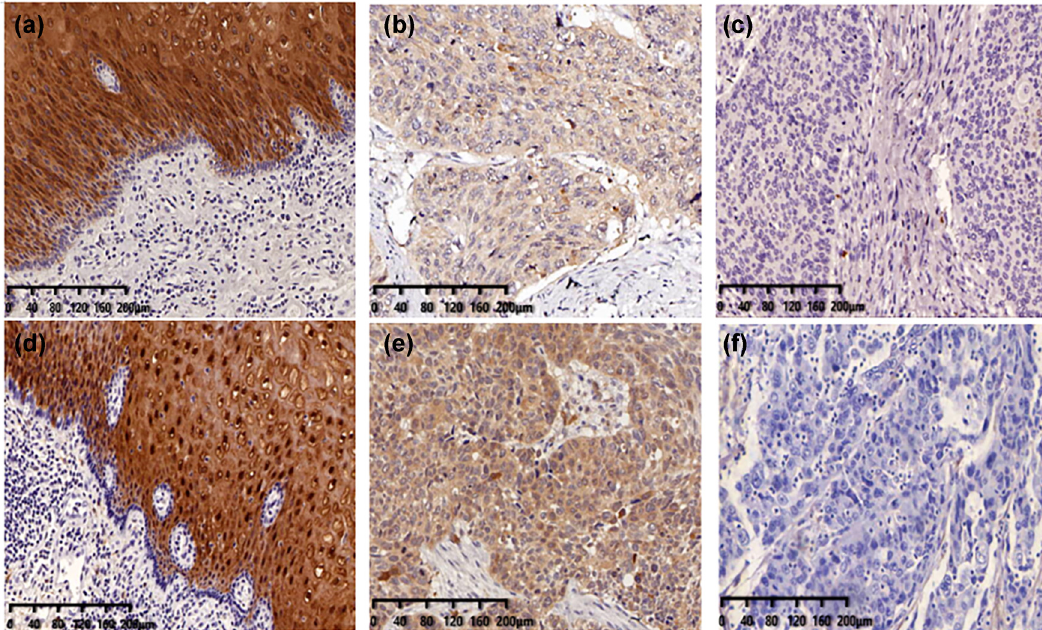
Figure 6: Immunohistochemical detection of the expression of CRABP2 and FABP5 in esophageal cancer and normal esophageal tissues. ( a and b ) CRABP2 is highly expressed in the normal esophageal squamous epithelium and esophageal squamous cell carcinoma; ( c ) low expression of CRABP2 in esophageal squamous cell carcinoma; ( d and e ) FABP5 is highly expressed in the normal esophageal squamous epithelium and esophageal squamous cell carcinoma; and ( f ) low expression of FABP5 in esophageal squamous cell carcinoma.